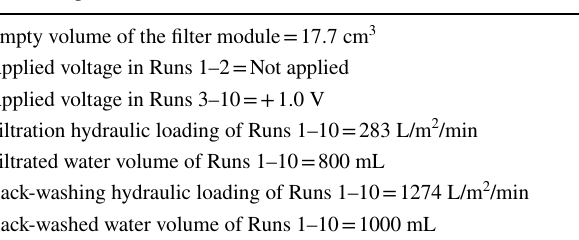
Table 1 Operational conditions of Runs 1–10 Empty volume of the filter module = 17.7 cm 3 Applied voltage in Runs 1–2 = Not applied Applied voltage in Runs 3–10 = + 1.0 V Filtration hydraulic loading of Runs 1–10 = 283 L/m 2 /min Filtrated water volume of Runs 1–10 = 800 mL Back-washing hydraulic loading of Runs 1–10 = 1274 L/m 2 /min Back-washed water volume of Runs 1–10 = 1000